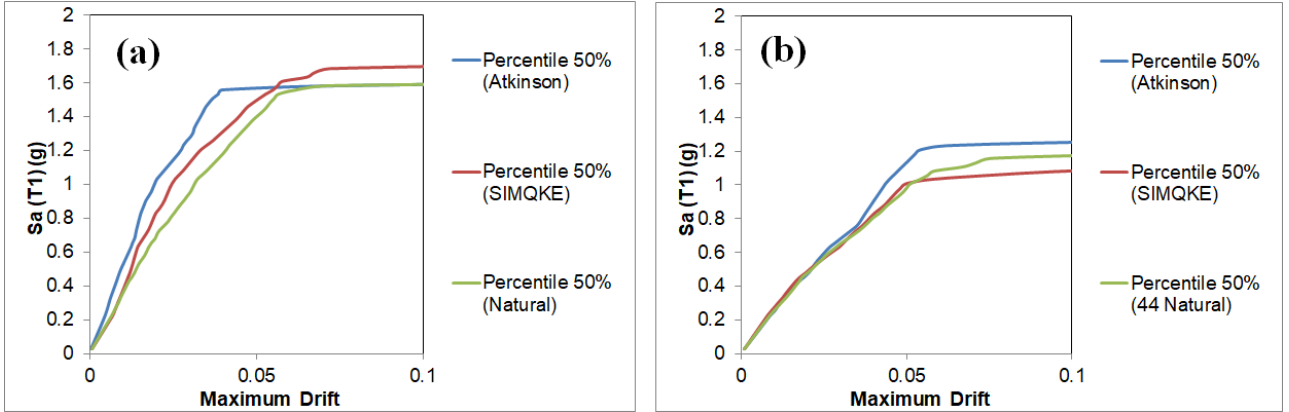
Figure 16. Comparison of the median IDA curve from different record sets for: ( a ) regular bridge and ( b ) irregular bridge.